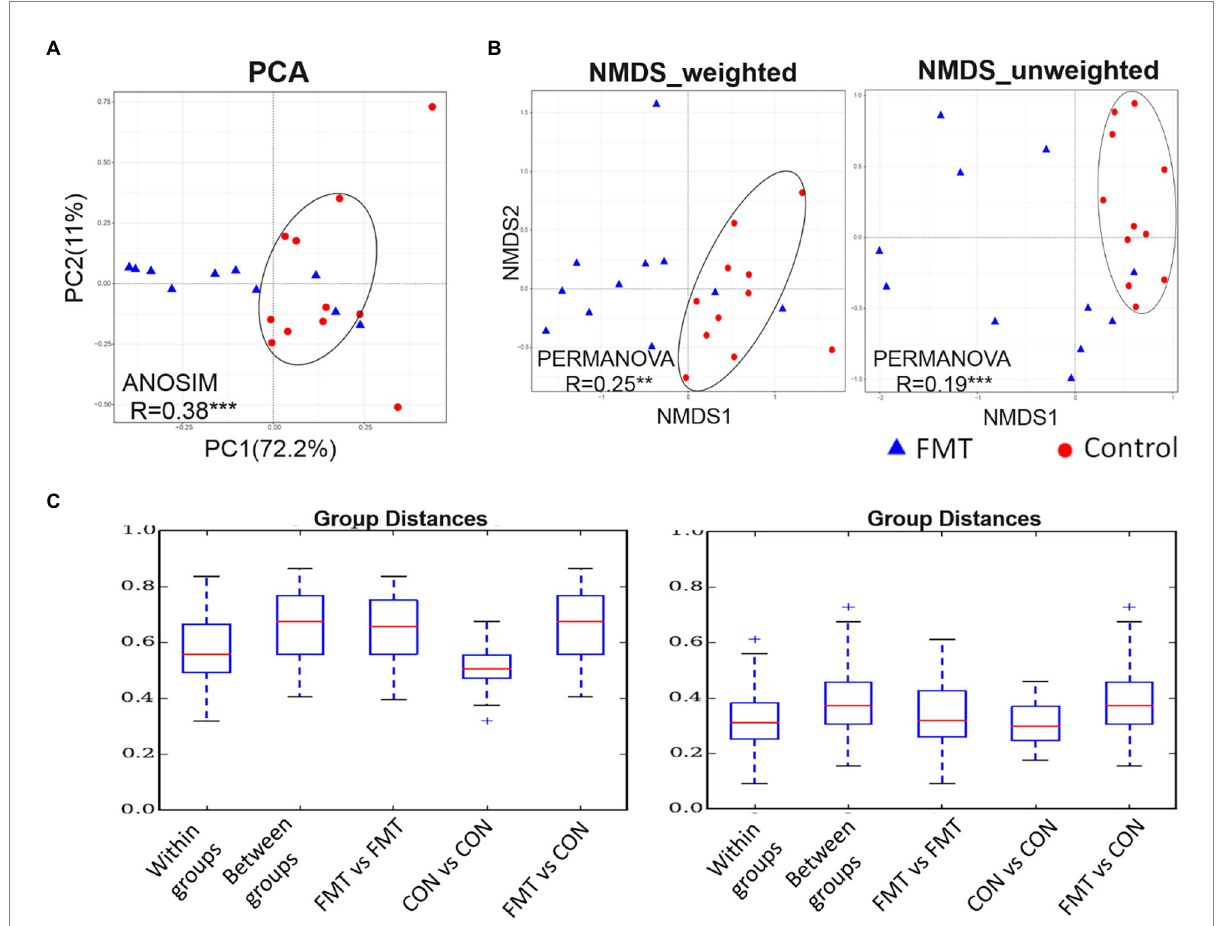
FIGURE 1 The PCA (principal component analysis) based on unweighted UniFrac distance. (A) the PCA, (B) non-metric multidimensional scaling (NMDS) of weighted and unweighted of unifrac distance, and (C) boxplot for comparative analysis of inter-group/group differences in unifrac distance between groups of control and FMT chicks. Two independent cluster showed significant correlated by ANOSIM (R = 0.38***) and PERMANOVA of weighted (R = 0.25**) and unweighted (R = 0.19***) of unifrac distance between control and FMT of